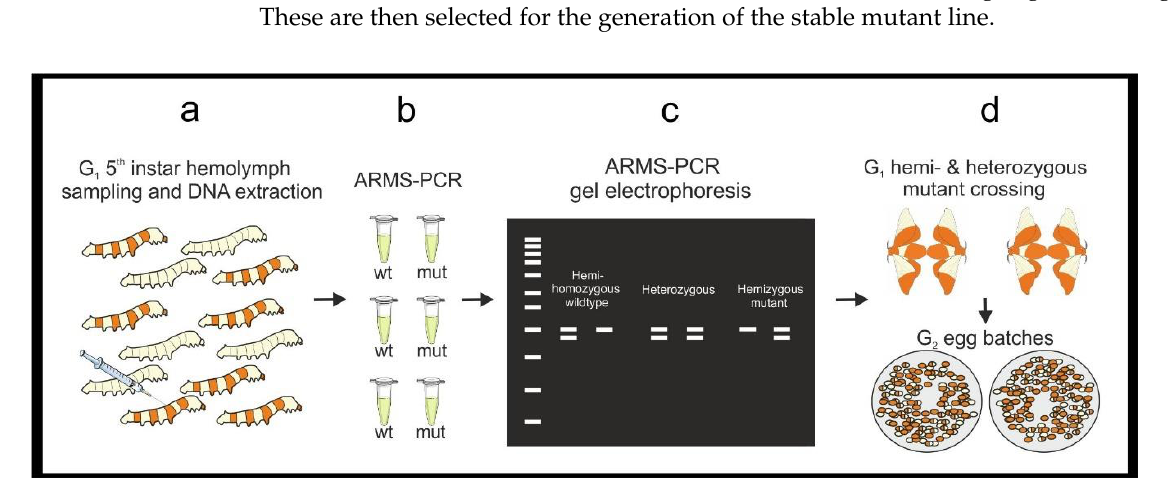
Figure 4. A workflow for hemolymph sampling, DNA extraction and screening with ARMS-PCR. ( a ) G 1 larvae bearing a target mutation are reared to the 5th instar. At the beginning of the 5th instar, hemolymph is sampled and DNA is extracted to perform ( b , c ) ARMS-PCRs identifying individual larvae carrying the mutation. ( d ) Appropriate larvae are then reared to adults and bred to generate G 2 egg batches bearing hemi-, hetero- and homozygote mutant individuals.